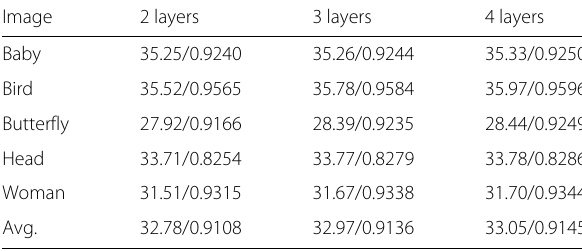
Table 2 The average PSNR (dB) and SSIM comparisons with our proposed method with different depths on Set5 [1] Image 2 layers 3